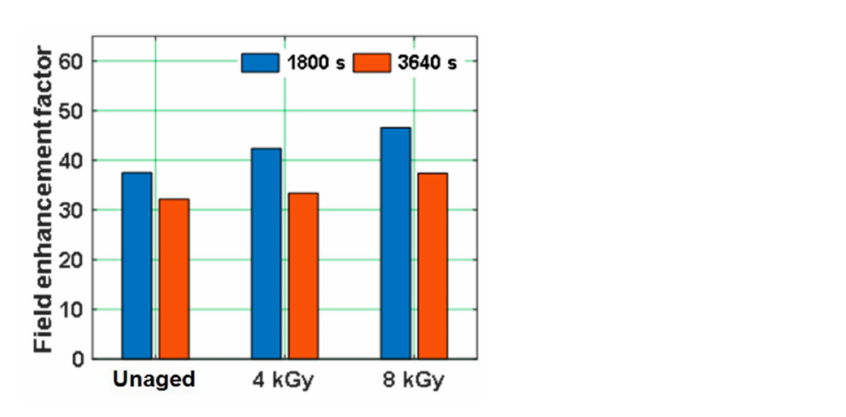
Figure 12. Field enhancement factor of unaged and gamma irradiated epoxy nanocomposites